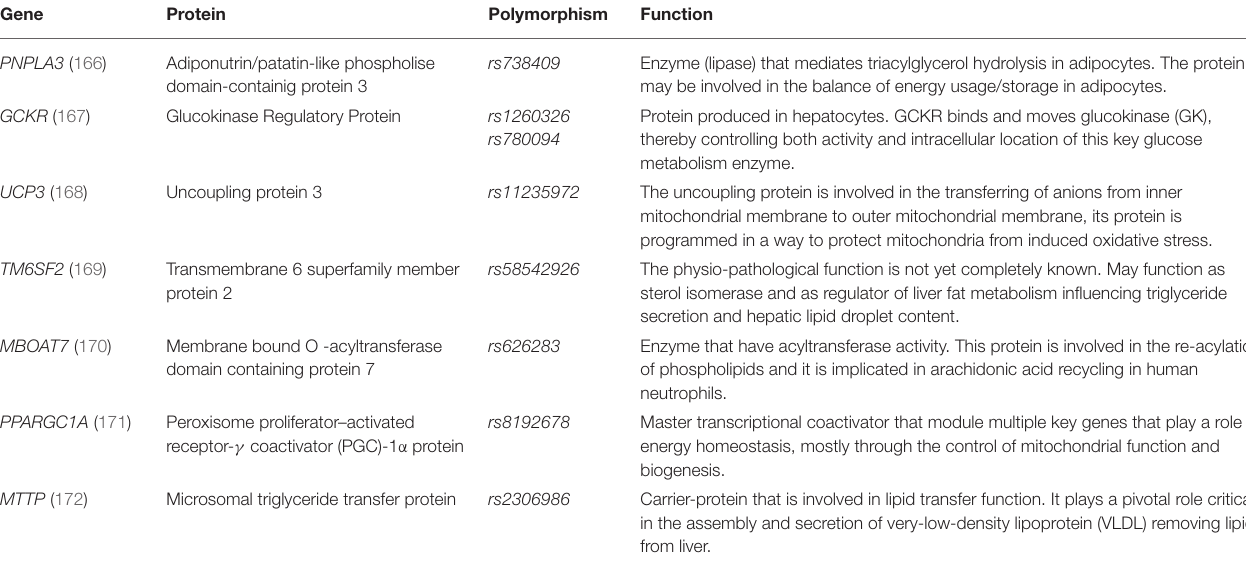
TABLE 2 | Genes implicated in the development of NAFLD and MetS in